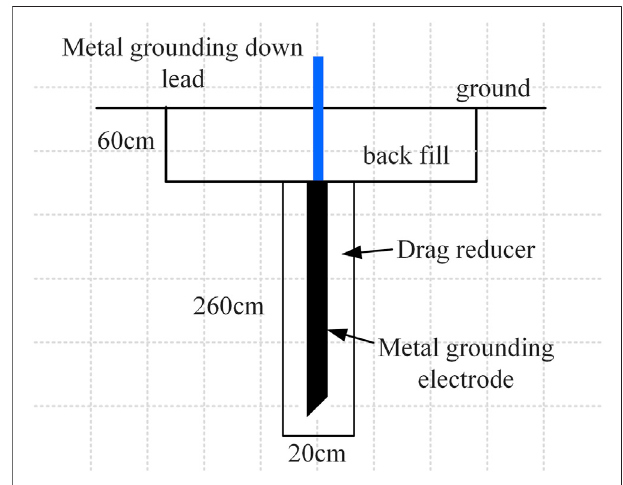
FIGURE 11 | Installation diagram of single improved grounding